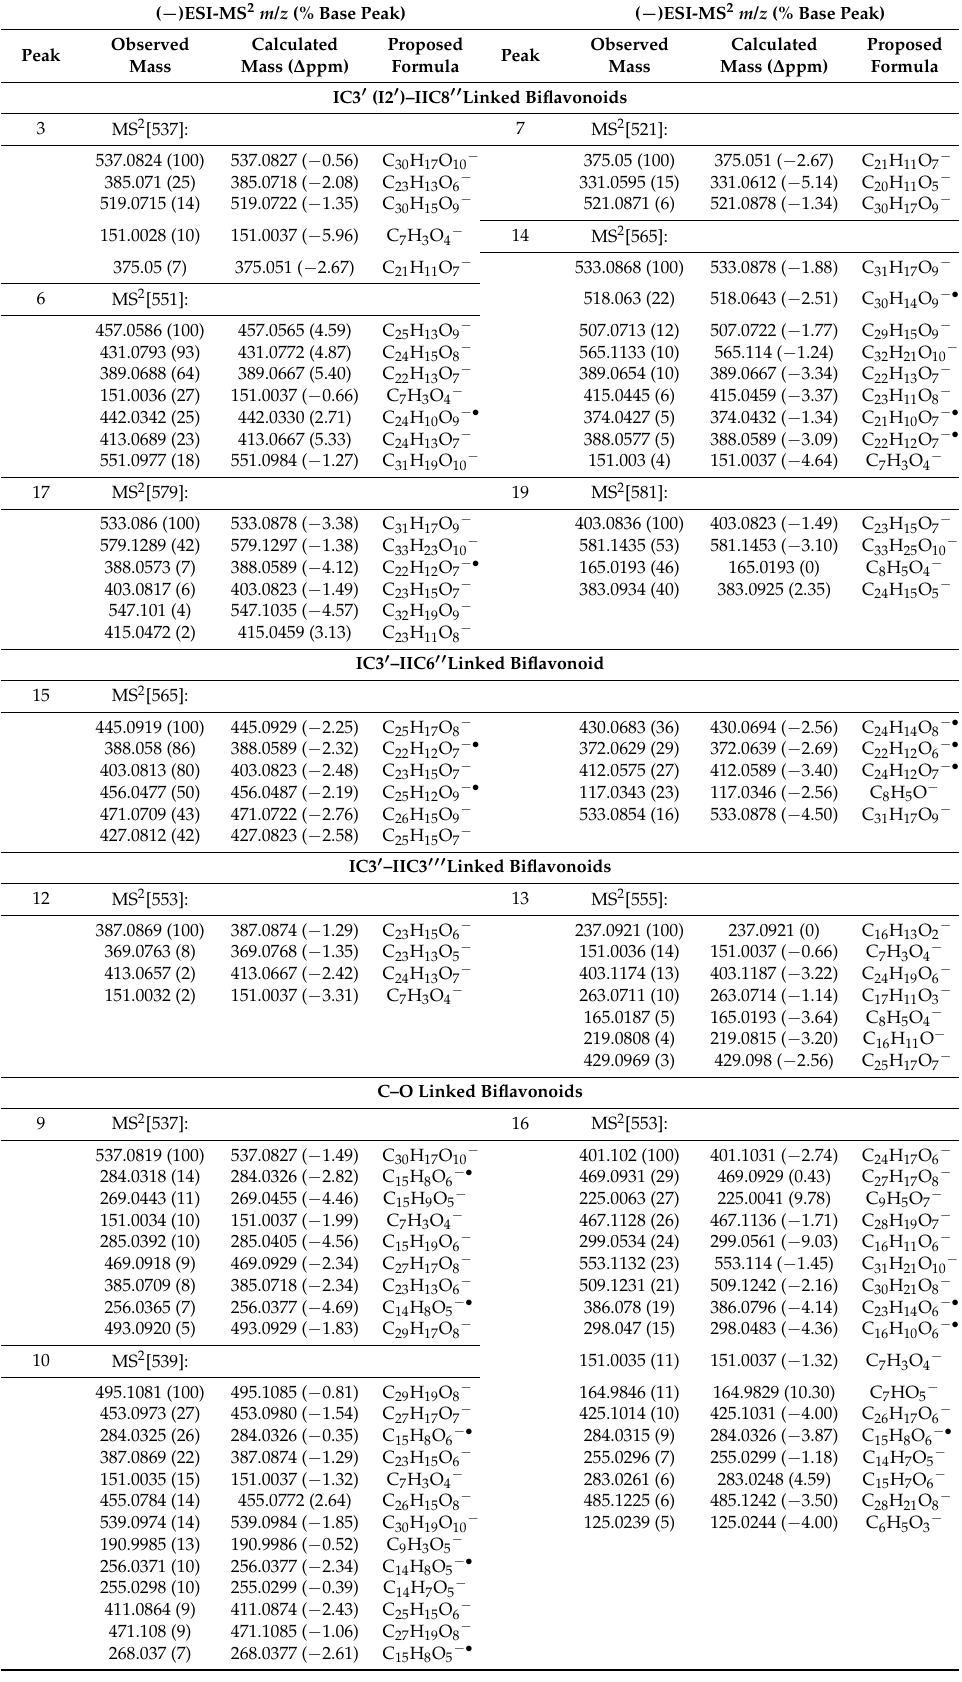
Table 2. Q-TOF MS/MS data obtained in ( − )ESI mode of biflavonoids of S. doederleinii . ( − )ESI-MS 2 m / z (% Base